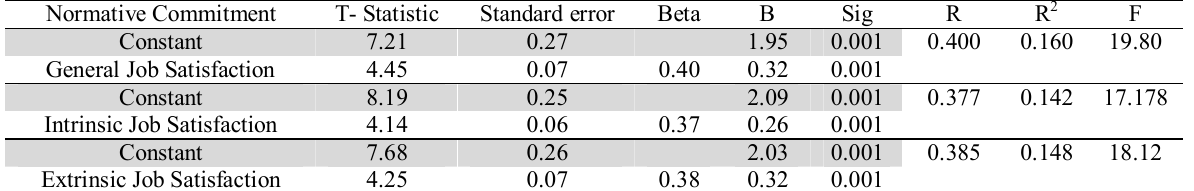
The regression analysis for predicting effect of intrinsic, extrinsic and general satisfaction on normative commitment Normative